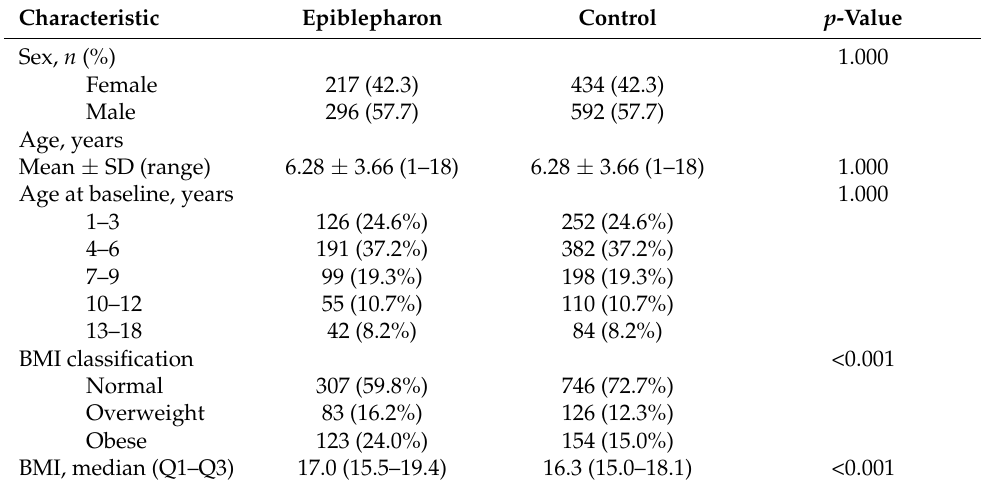
Table 1. Demographic characteristics of